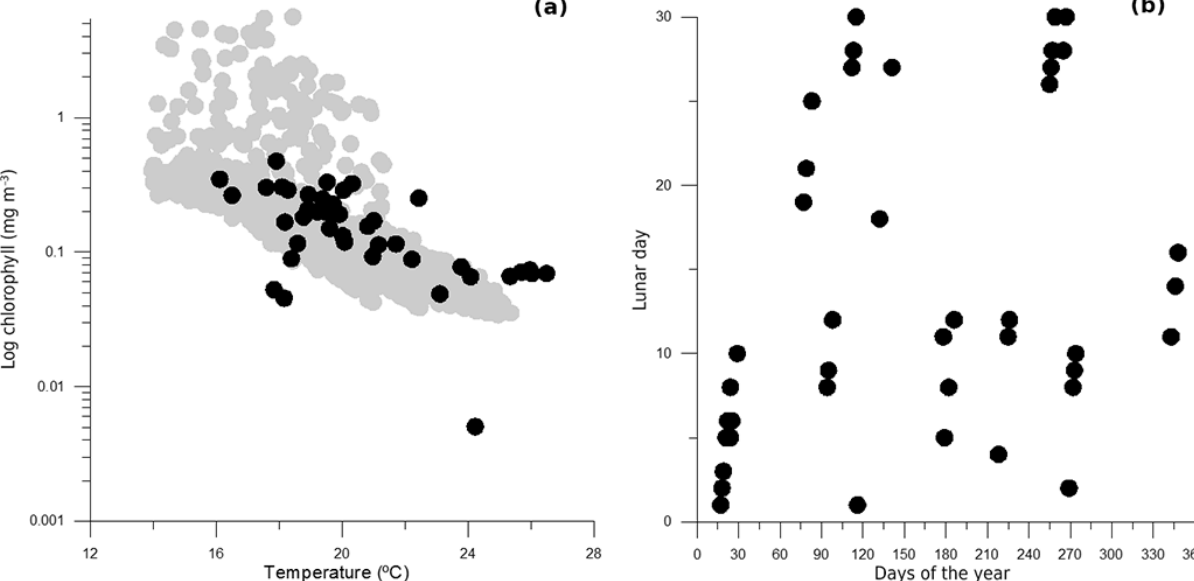
Figure 3. Coverage of the ecological space of planktonic foraminifera in the studied region by the sampled stations. (a) Gray symbols show the covariance between mean monthly SST (sea-surface temperature) (MIMOC: Monthly Isopycnal/Mixed-layer Ocean Climatology; Schmidtko et al., 2013) and chlorophyll (MODIS-Aqua 2003–2013 Data, NASA) concentration for every grid at 2 ◦ × 2 ◦ resolution in the studied region (Fig. 1). Dark symbols show the in situ values for the two parameters at the time of sampling for the studied plankton net stations. (b) Seasonal coverage of the lunar cycle by the studied sampling